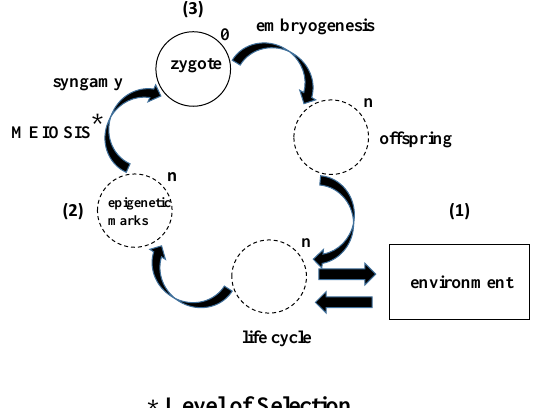
Figure 1. Epigenetic evolution: In contrast to the conventional way in which evolution is seen from the perspective of the adults to the offspring, this schematic portrays the process as Lamarckian evolution from the perspective of the germline cells interacting with the environment. Over evolutionary time (symbolized by the genomic multiplier “n”, reduced back to “0”, based on First Principles of Physiology in the zygote), ( 1 ) the epigenetic marks accumulated from the environment are ( 2 ) processed during meiosis, determining which “marks” are assimilated or rejected; ( 3 ) The processing of the zygote to form the offspring during embryogenesis further determines whether epigenetic marks are incorporated into the genome or not.